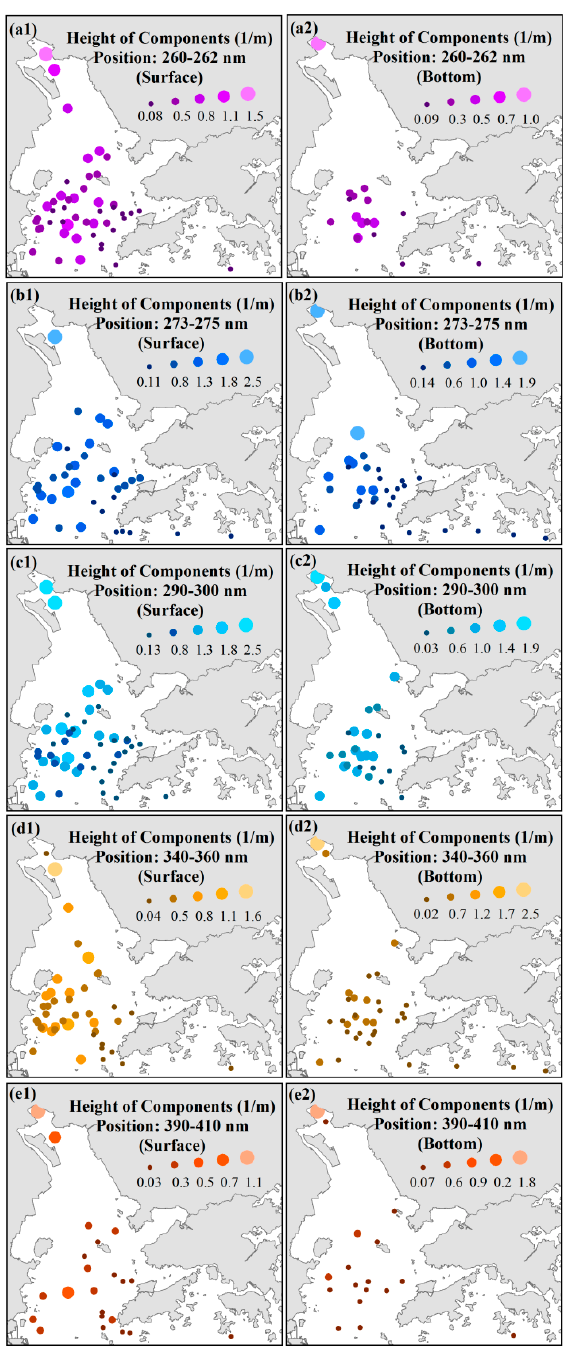
Figure 9. Surface and bottom variations of peak height of Gaussian components in groups centered near wavelengths of ( a ) 260, ( b ) 275, ( c ) 300, ( d ) 350, and ( e ) 400 nm. The size of the dots denotes the peak height: the bigger the size, the higher the peak.